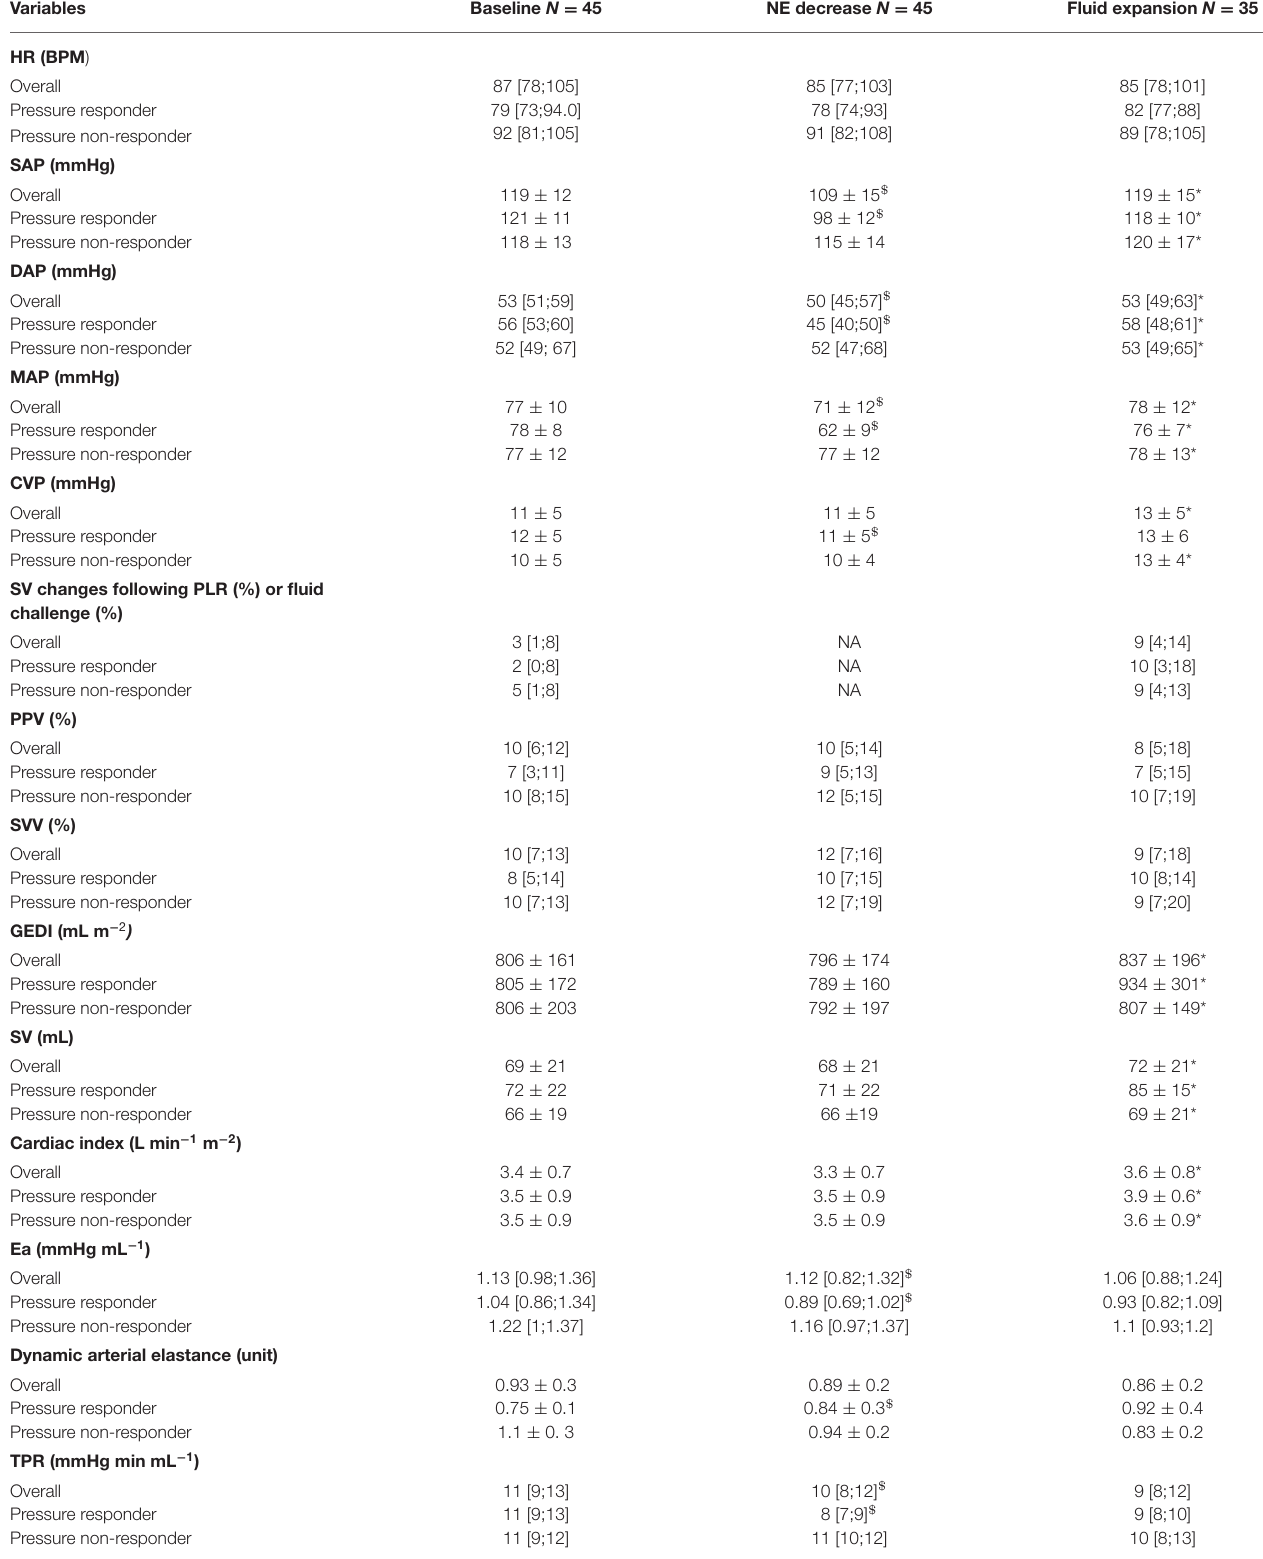
TABLE 2 | Hemodynamic evolution following hemodynamic interventions.